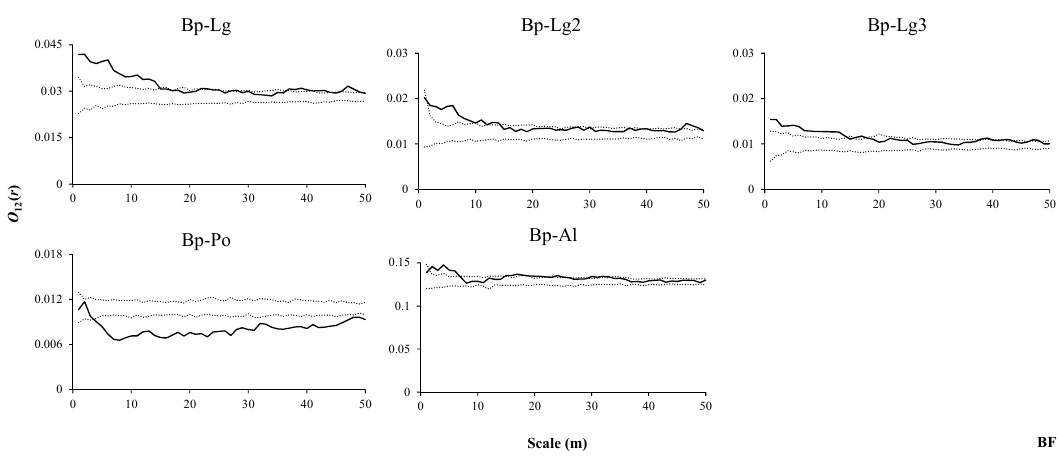
Figure 8. Spatial associations between B. platyphylla and other tree species in BF.